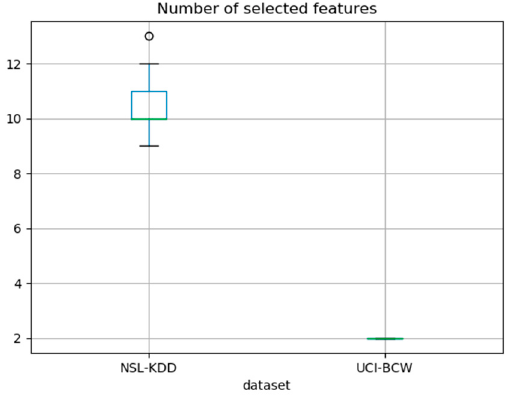
Figure 5. Number of selected features for each dataset, shown as boxplots.